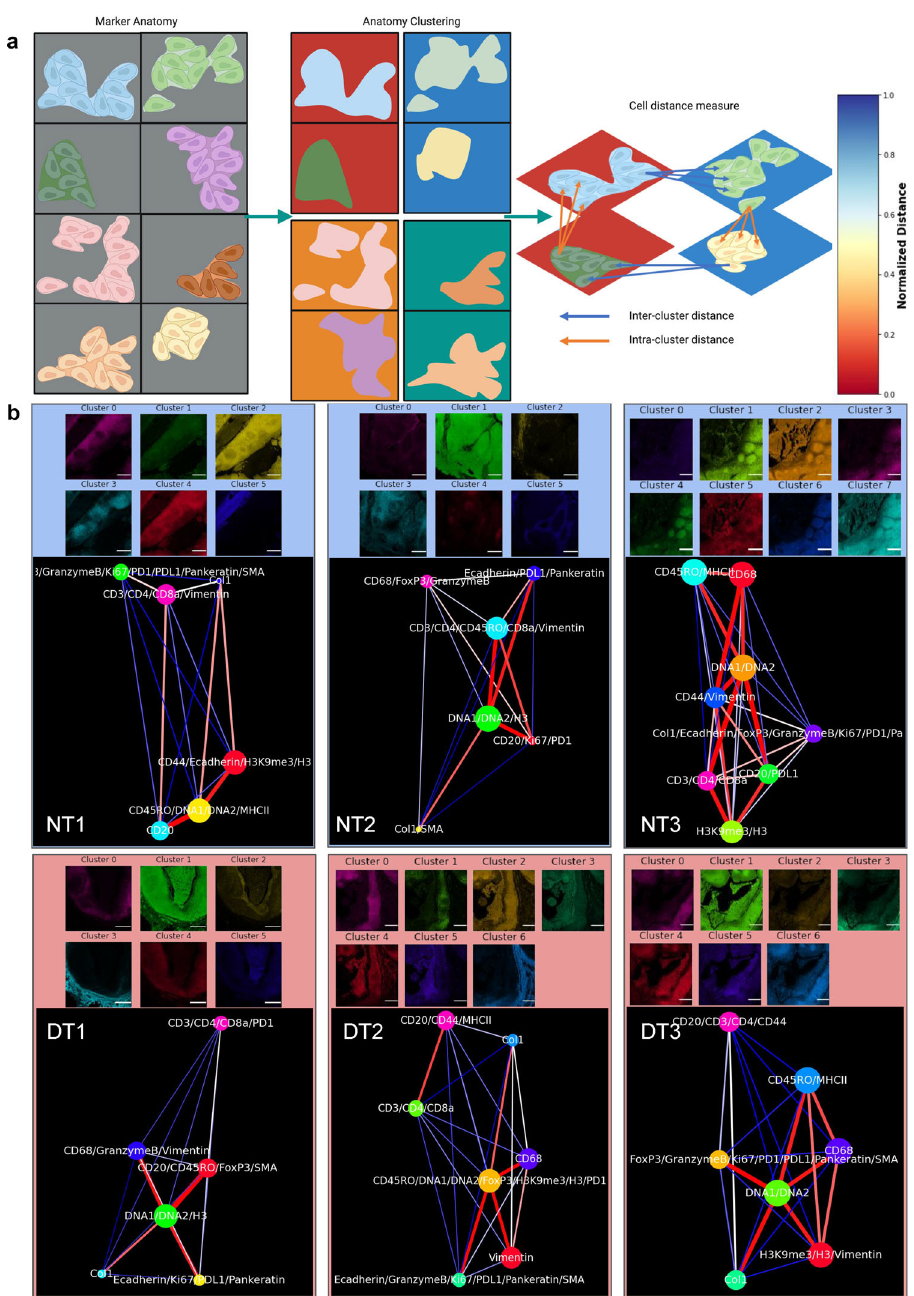
Fig. 4 Inter-cluster distances across anatomical classes were represented as spatial network maps of single-cell positions and expression levels. a Schematic representation of intra-cluster and inter-cluster models among the single-cell locations is presented. Unsupervised clustering was performed on multiplexed IMC data to de fi ne anatomical regions. Spatial network visualization plots of marker pairs from intra-cluster (denoted with orange arrow) and inter-cluster (indicated with blue arrow) using relative distances between single-cell positions for each marker (scale bar 500 µ m) are shown. Created in Biorender.com. b Inter-cluster distances provide spatial network maps of single-cell pairs across anatomical clusters computed for normal and disease tonsil datasets. Red edges between network nodes show short average distances, whereas blue ones demonstrate relatively distant average measurements (scale bar 500 µ